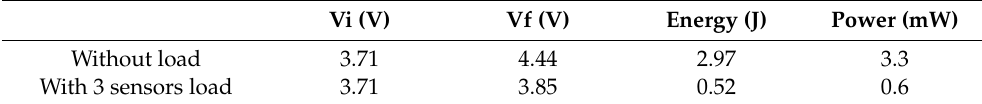
Table 5. Energy stored during 900 s at 0.2 Hz movements, and respective mean power .